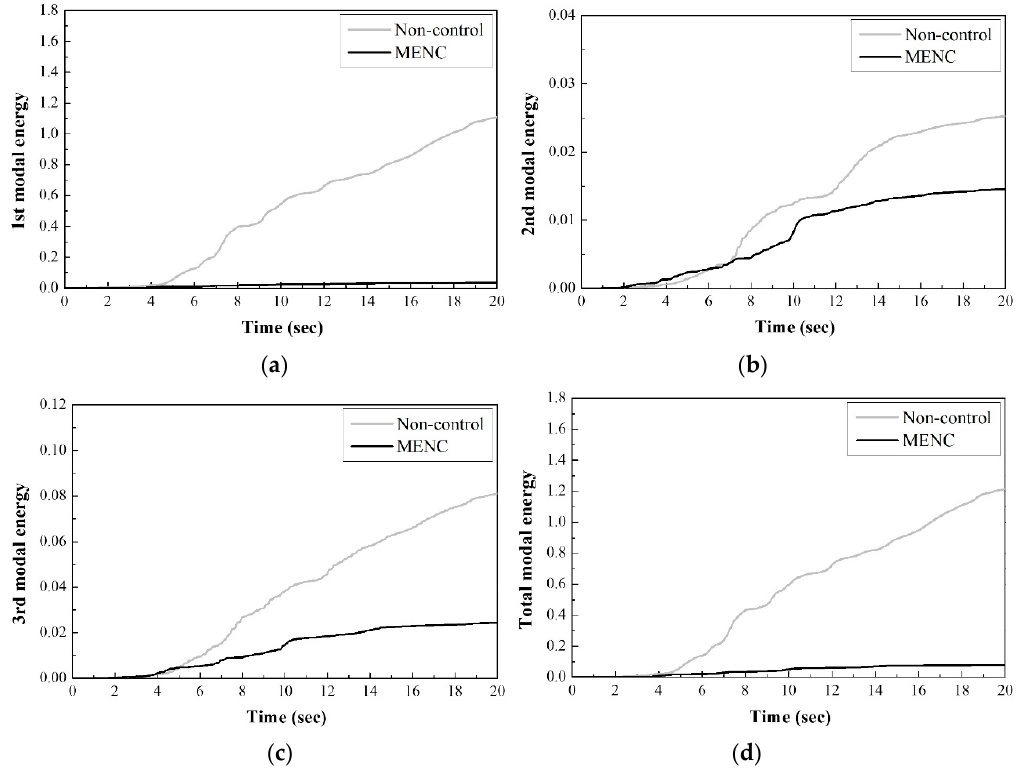
Figure 10. Comparison of modal energies in the control and non-control of the building structure under the California earthquake: ( a ) first modal energy; ( b ) second modal energy; ( c ) third modal energy; ( d ) total modal